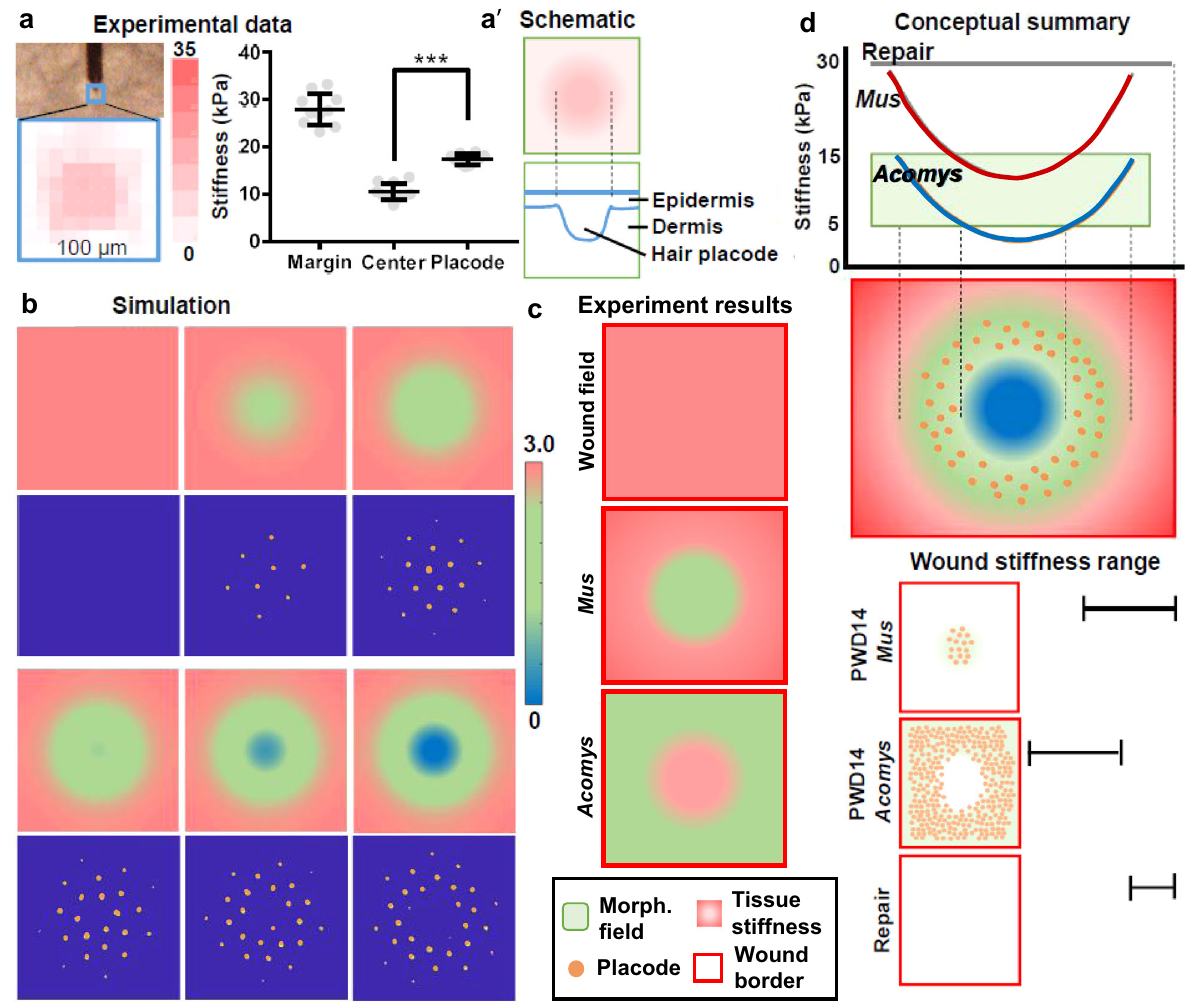
Fig. 6 Multiscale tissue mechanics set up morphogenetic fi eld for WIHN. a AFM stiffness mapping demonstrates the stiffness of the hair placode. This is based on experimental data. Top left: an AFM cantilever scanning a PWD14 wound. Blue box demarcates the 100 × 100 μ m scanning area. Below: stiffness heatmap of a placode. Colorimetric unit: kPa. Right panel: Dot plot showing the stiffness of placode with respect to wound margin and center. Representative image of 3 out of 3 experiments. n = 9 regions examined over 3 independent biological animals. Data are presented as mean values ± SD. p < 0.0001, unpaired two-sided t -test. a ′ Schematic diagram of placode stiffness and its respective cross-sectional view. b Hypothetical model showing feedback loop in a Turing system with an underlying measure of stiffness. Simulations illustrating stationary distributions of u (activator, blue background blocks) and E (stiffness, pick background blocks) with increasing s (source coef fi cient, measures the strength of the E source). The underlying domain is a square of side length 100 and the color shows the value of S at each grid point, S( x , y ). The ‘ size ’ of the soft region is controlled by σ . From left to right and then the row below, the values of s are 2, 4, 6, 8 and 10, and σ = 20. In all cases random initial conditions from a uniform distribution of [0.5, 1.5] are used. c Schematic drawing showing the opposite topology of morphogenetic competent and non-competent region in the wound bed. d Conceptual summary of the way we perceive the relationship between tissue stiffness and morphogenetic fi eld (Top). Summary based on data from Figs. 1 and 2. Middle: It highlights the different geographic distribution of the morphogenetic fi eld (green) within a wound bed (red frame), and also the periodic appearance of hair primordia (orange) within the morphogenetic fi eld (green). When the wound stiffness is too low (blue), no placode can form. Bottom: Stiffness of different wound beds predicate distribution of morphogenetic fi eld and placode